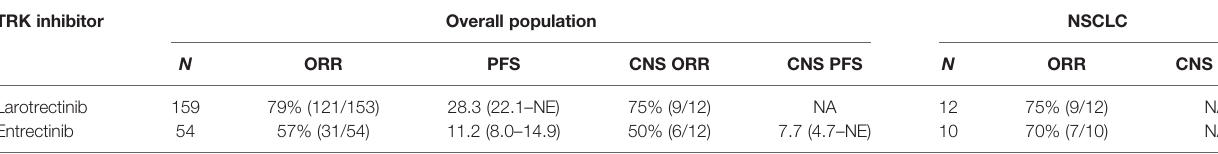
TABLE 1 | The ef fi cacy of the fi rst-generation TRK inhibitors. TRK inhibitor Overall